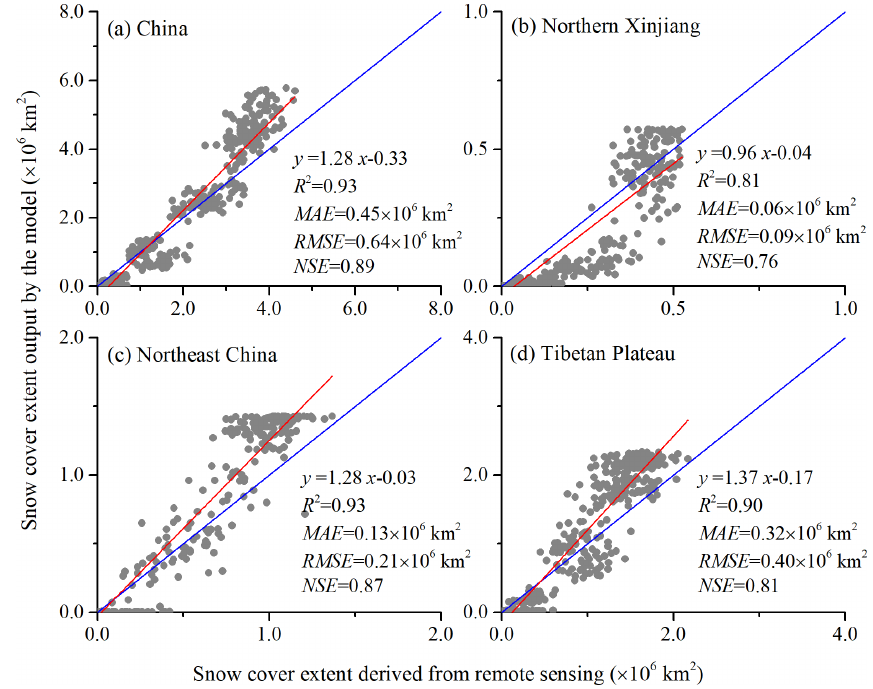
Figure 5. Scatterplots of the snow cover extent output by the model and information derived from remote sensing in China and its three main stable snow cover regions. The red and blue solid lines are the linear fit and the 1 : 1 line,